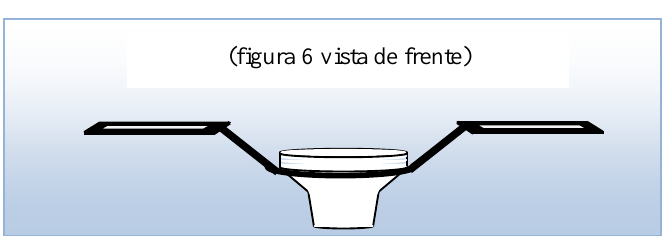
Figura 6. Mostra o KITLAB fora do vaso, desdobrado, com a sua cuba central.